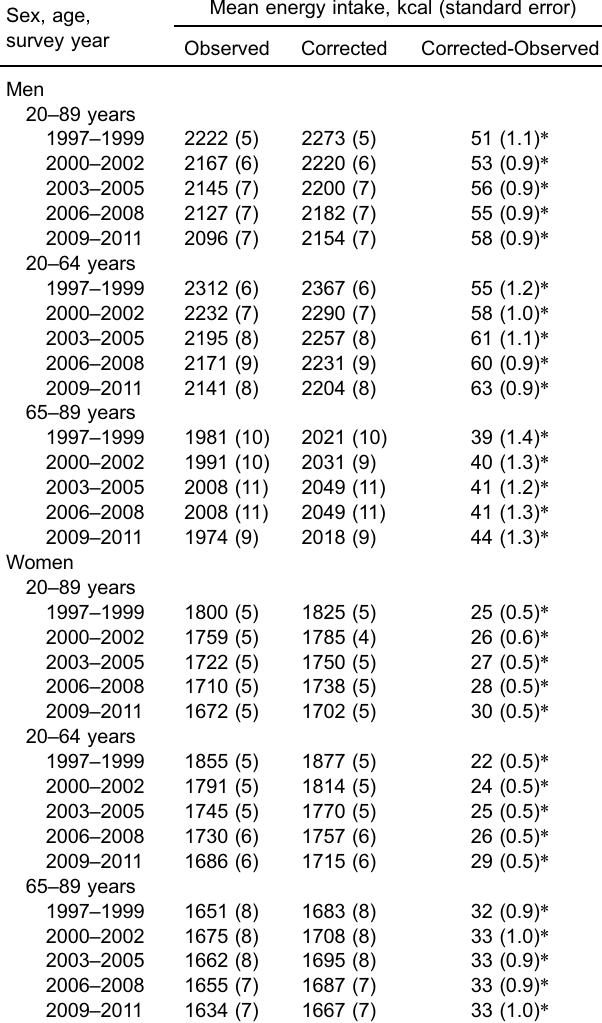
Table 5. Observed and corrected means of total daily energy intake in the Japanese population, by age group, sex, and 3-year survey period Sex, age, survey